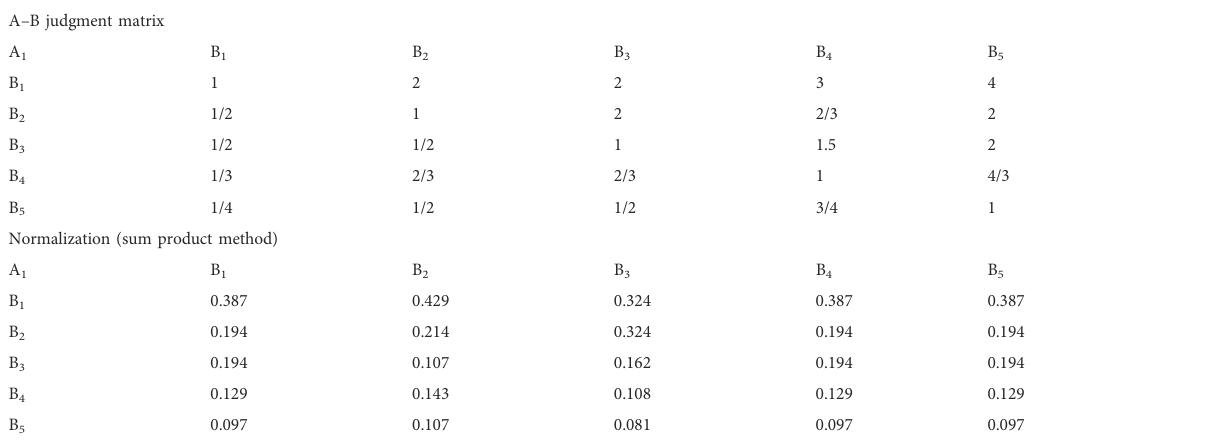
TABLE 5 A – B judgment matrix and Normalization of the AHP model.